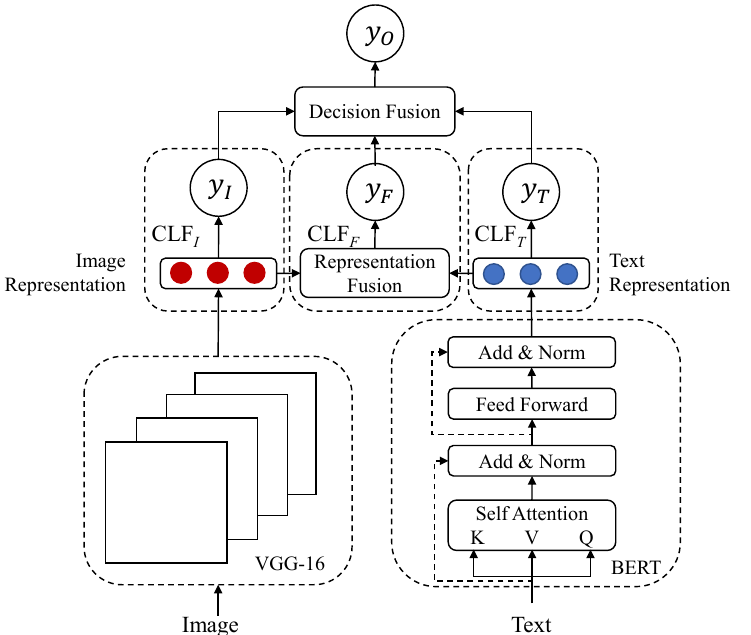
Figure 3. HFN (Hybrid Fusion Network) consists of two feature extractors, three individual classifiers, a representation fusion module, and a decision fusion